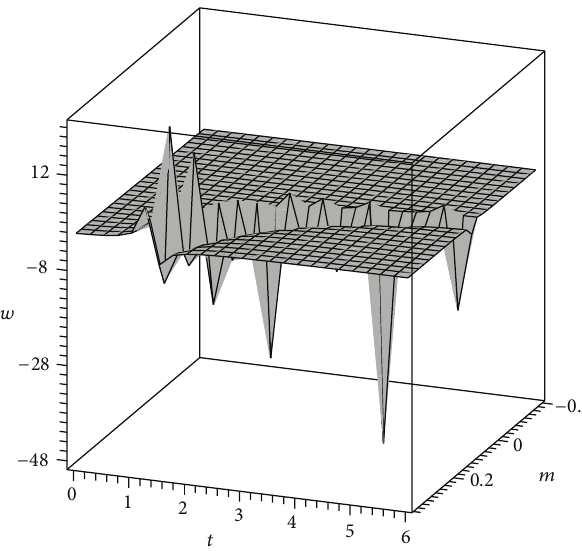
Figure 6: 𝜔 𝜙 vary for different values of the vector field by 𝑚 and 𝑡 for 𝑛 = 3 and 𝜁 = −2 . Positive values of 𝜁 do not show a phantom divided line crossing. The values of 𝜁 are obtained with